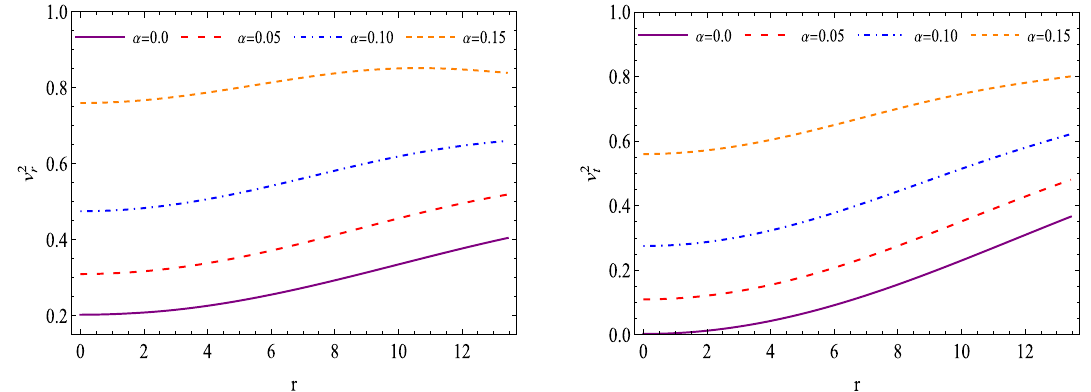
Fig. 2 The figures show the variation of effective density ( ρ tot )-top left, radial pressure ( P tot r )-top right panel, tangential pressure ( P tot t )- bottom left panel and anisotropy ( (cid:18) tot )-bottom right panel versus radial